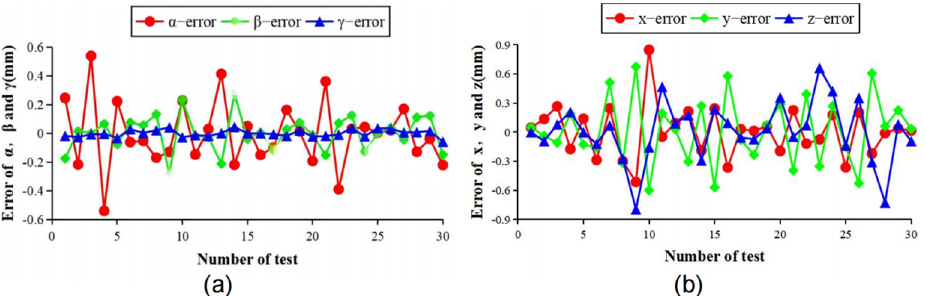
Figure 20. Accuracy verification experiment results: ( a ) Error of α , β , and γ ; ( b ) Error of x, y, and z.